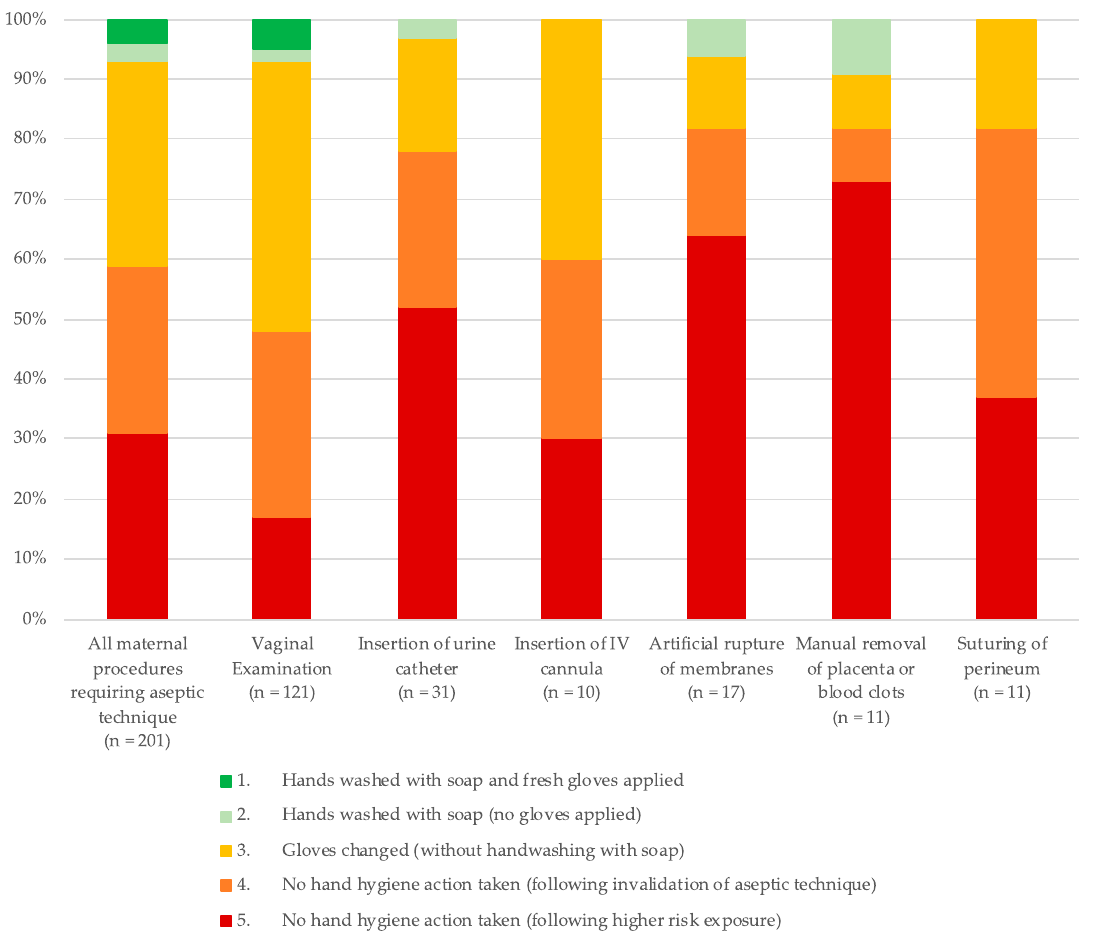
Figure 2. Hygiene categories during individual mother-specific procedures requiring aseptic technique. VE: vaginal examination.